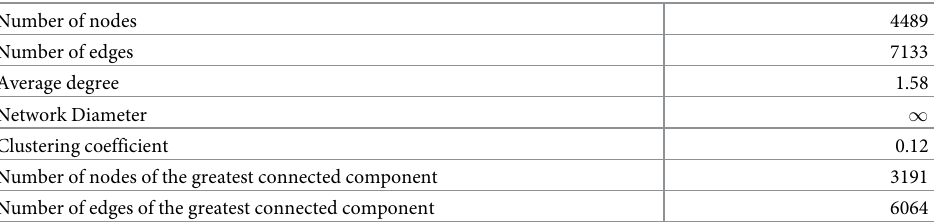
Table 8. Characteristics of the administrative decrees network.